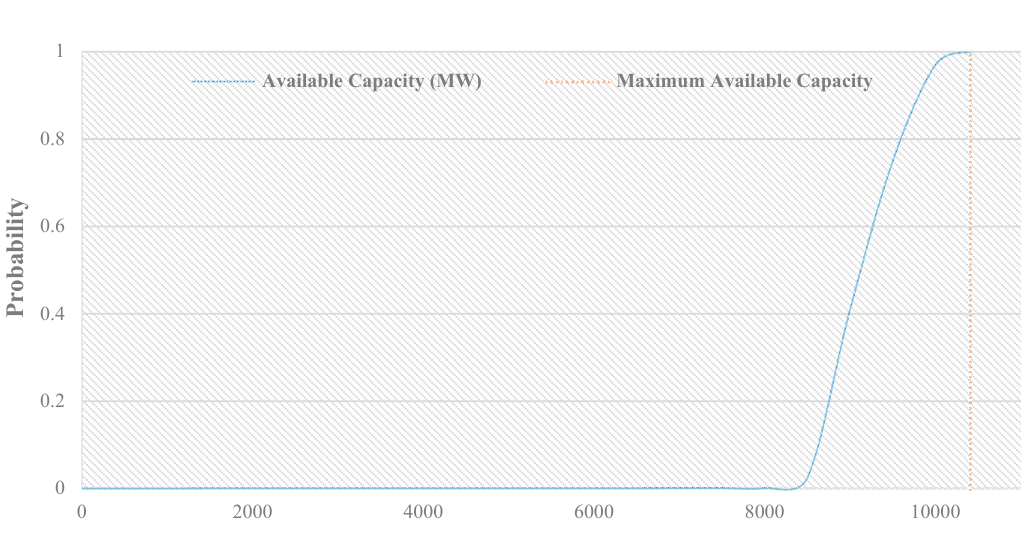
Figure 15. Capacity outage probability table (COPT) curve for the electricity market in Greece as a function of the system’s available capacity.